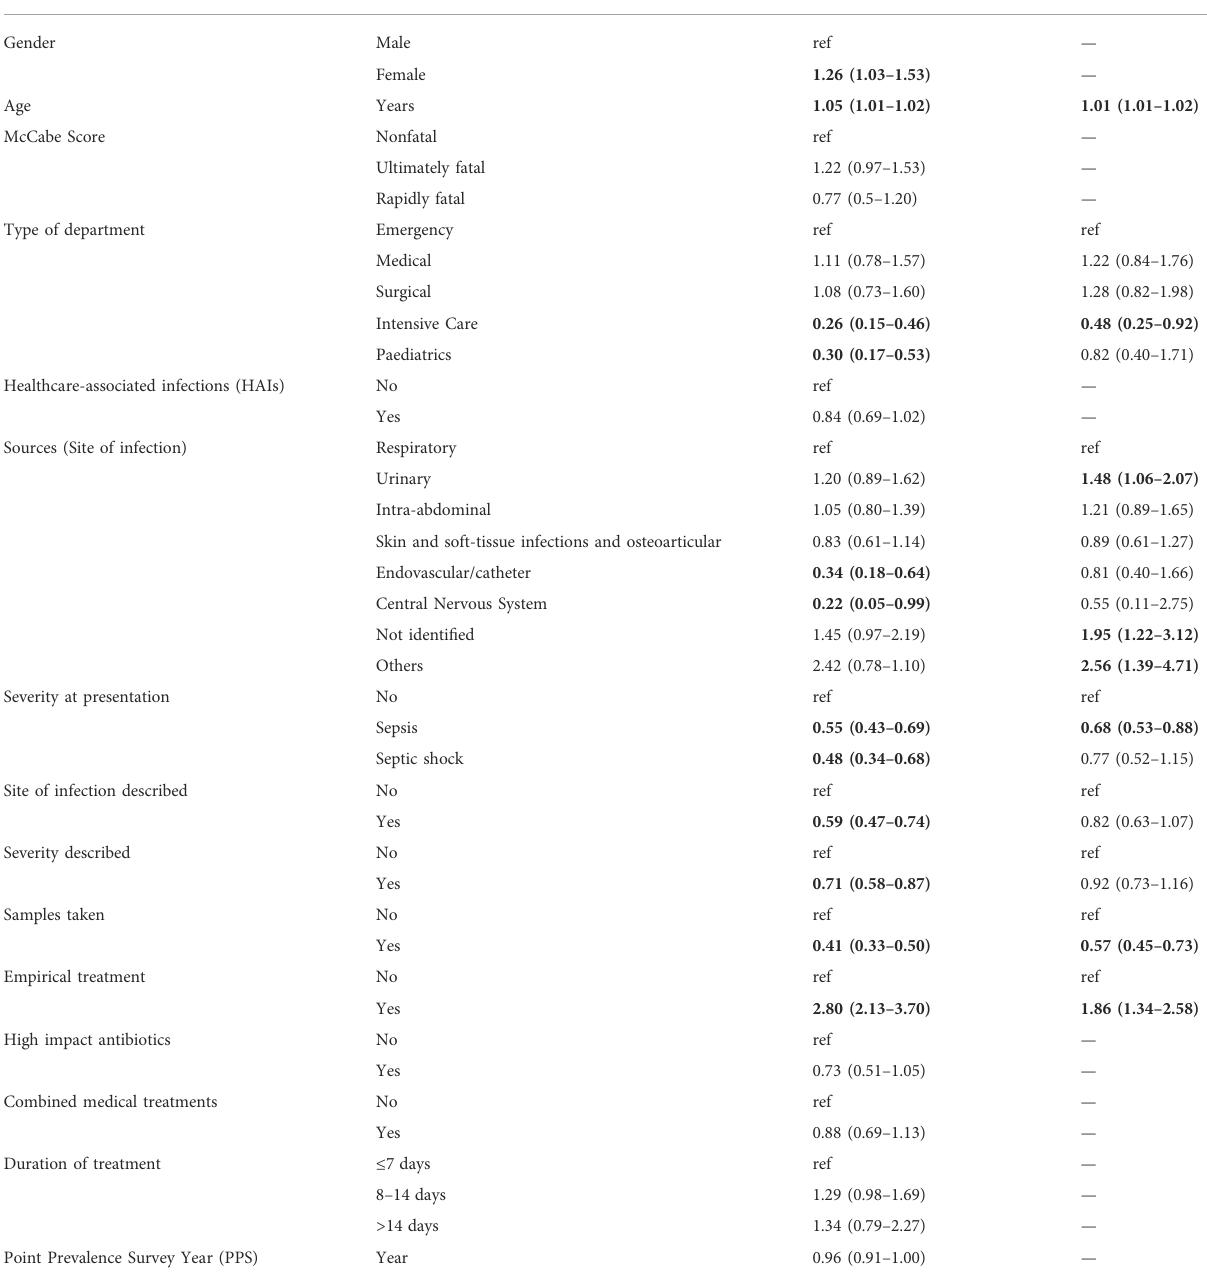
TABLE 2 Univariate and multivariate analysis of risk factors associated to inappropriate antimicrobial prescription.